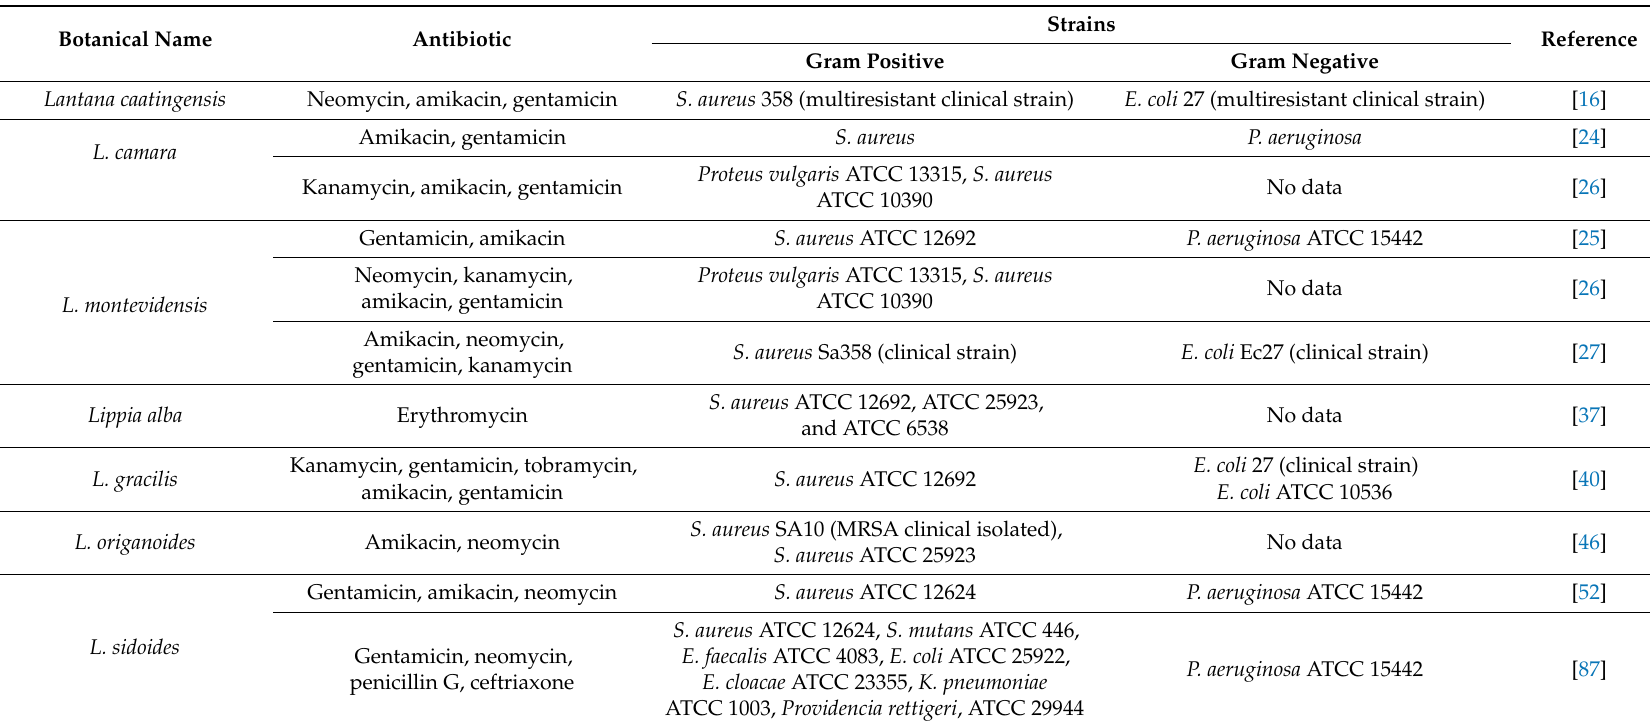
Table 3. Synergistic interactions between EOs of plants belonging to the Verbenacea family and antibiotics used for human infectious